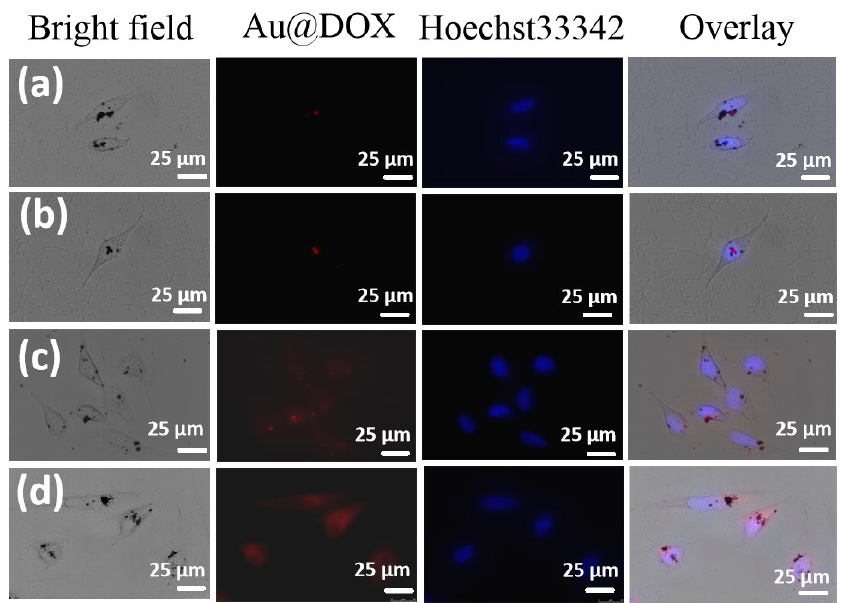
Figure 4. Distribution in HepG2 cells in response to the treatment with Au@MPA-PEG-HA-ADH- Dox at different concentrations. ( a ) 50 μ g/mL, ( b ) 100 μ g/mL, ( c ) 150 μ g/mL, and ( d ) 200 μ g/mL. Scale bars = 25 μ m.